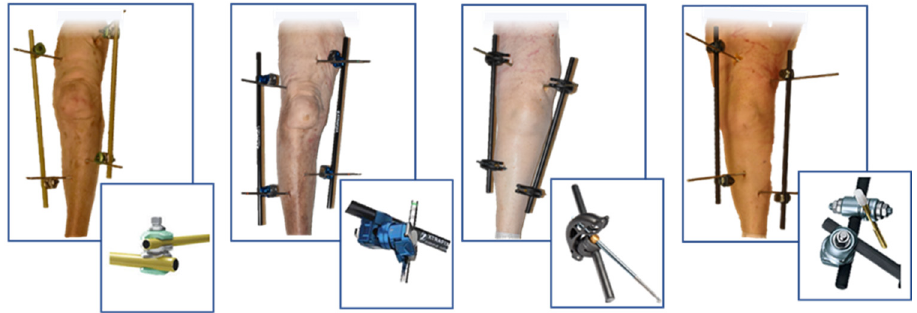
Figure 1. Example of the legs instrumented with the four brands of external fixators by “H” configu- ration. Down from left are reported samples of the devices of Hofmann III ® , XtraFix ® , Dolphix ® and Large E.F. ® .